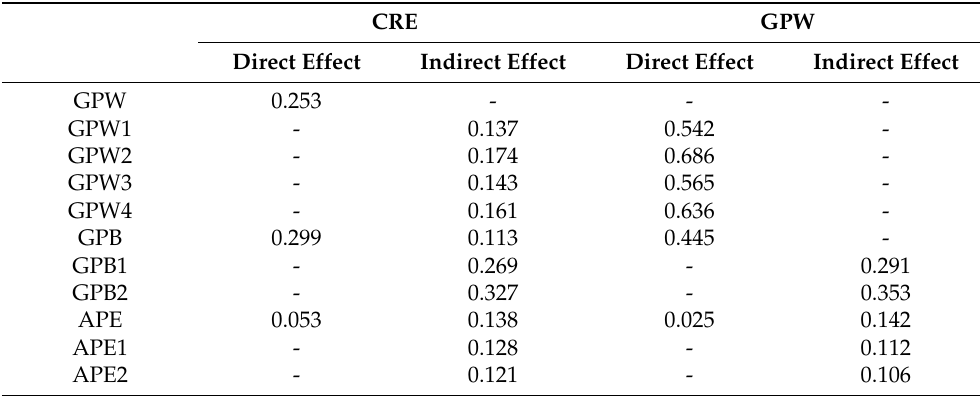
Table 8. Standardized direct and indirect effects.